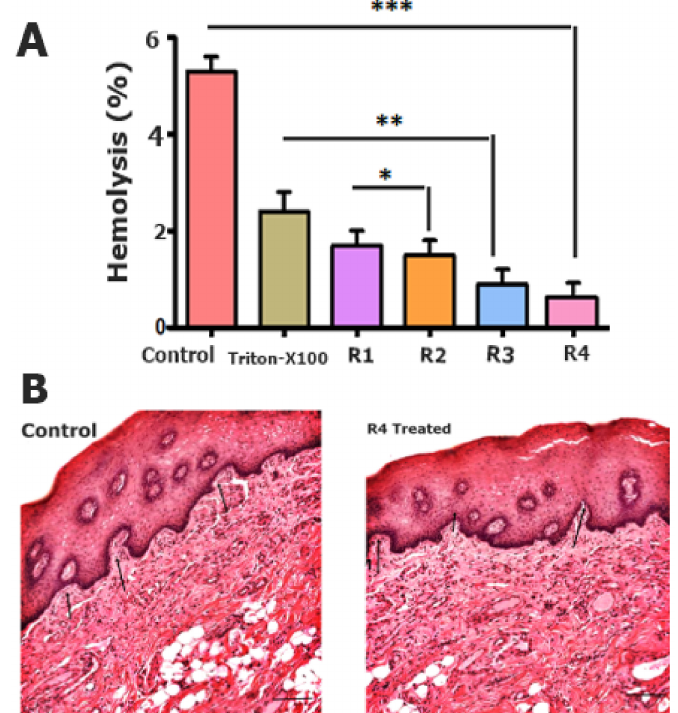
Figure 7. In vitro hemolytic (%) assay ( A ). The p value less than 0.1, 0.01 and 0.001 were denoted with *, ** and *** respectively; and histopathological evaluation of the buccal mucosa ( B